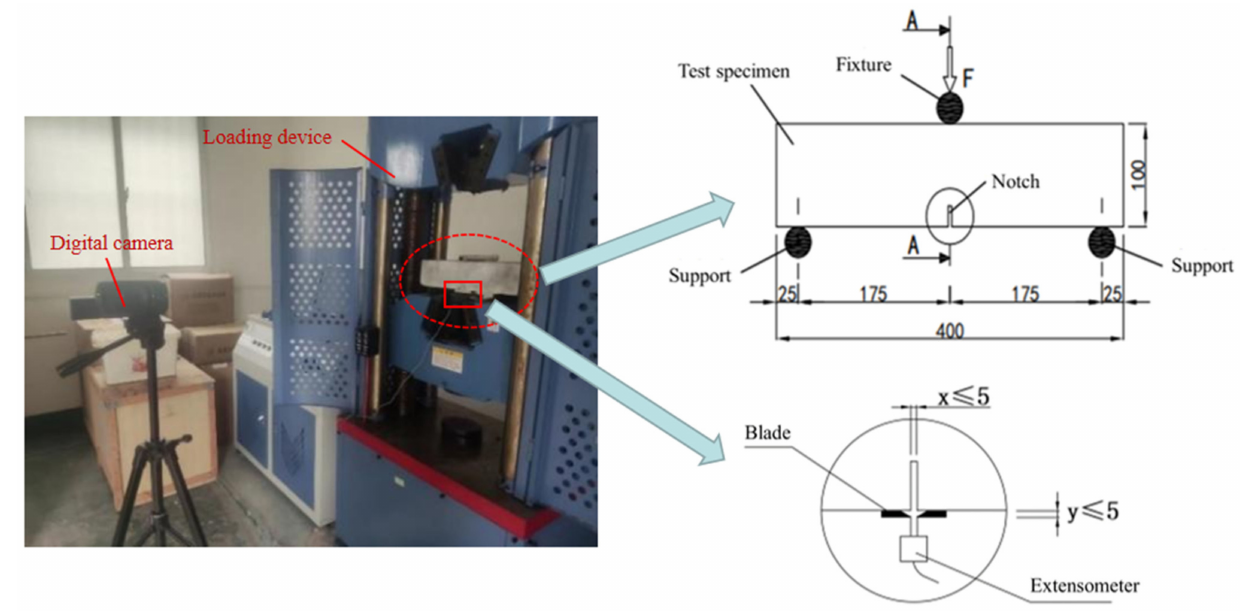
Figure 2. Setup figure of the CMOD test (unit: mm)